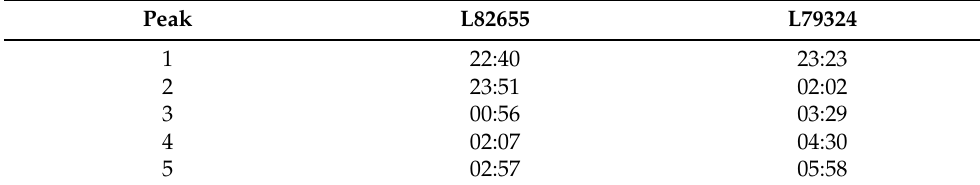
Figure 4. Selection of time instances for analysis for observation ( a ) L82655, ( b ) L79324. Table 1. UT time of the peaks for the selected intervals.